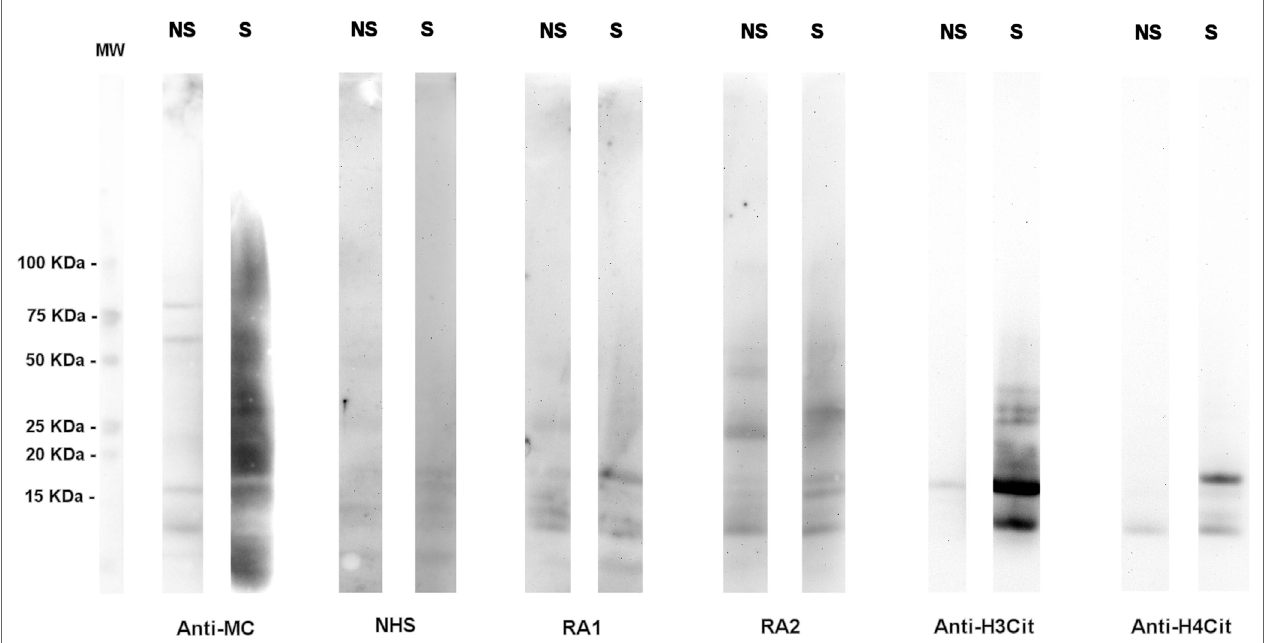
FiGURe 1 | A high number of citrullinated proteins is produced in neutrophils upon stimulation . Total proteins from A23187-stimulated (S) or unstimulated (NS) neutrophils were subjected to SDS-PAGE and western blotting and probed with an anti-modified citrulline human monoclonal antibody (anti-MC), NHS or RA sera, anti-citrullinated H3 (anti-H3cit), or anti-citrullinated H4 (anti-H4cit) polyclonal antibodies. Anti-MC h-mAb decorates a high number of proteins in stimulated neutrophils, part of which are recognized by RA sera. Proteins of 10–15 KDa are bound by anti-MC h-mAb, by RA sera, and by anti-H4cit or anti-H3cit antisera, thus suggesting that in stimulated neutrophils, H3 and H4 are citrullinated and become target of RA immune response, as previously showed (57, with the permission of BMJ Publishing Group, N°